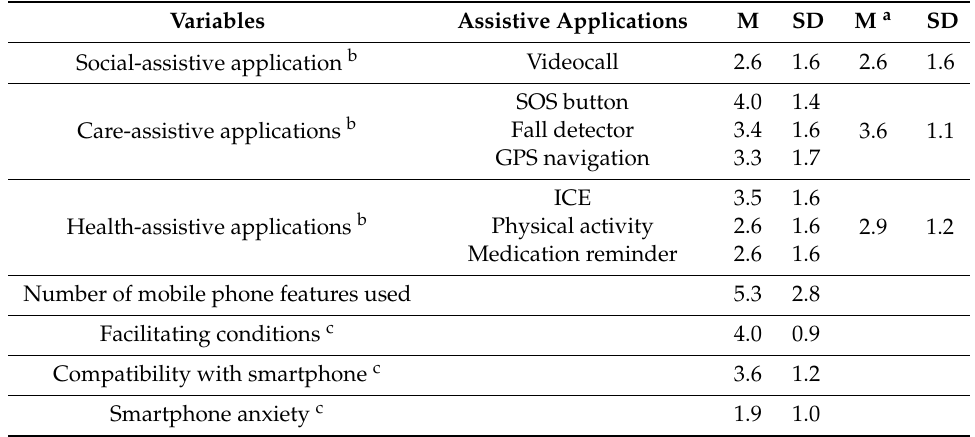
Table 3. Interest in assistive applications and agreement with smartphone-related dispositional